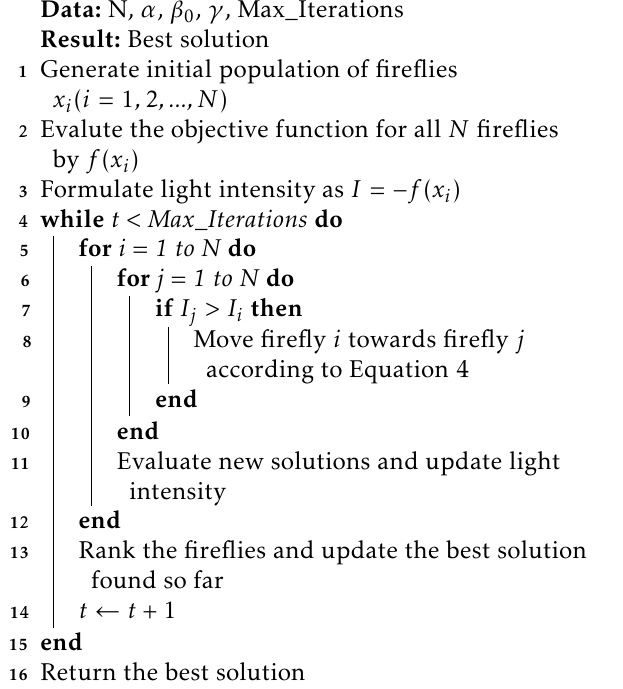
Algorithm 1: Pseudocode of the Firefly Algo-